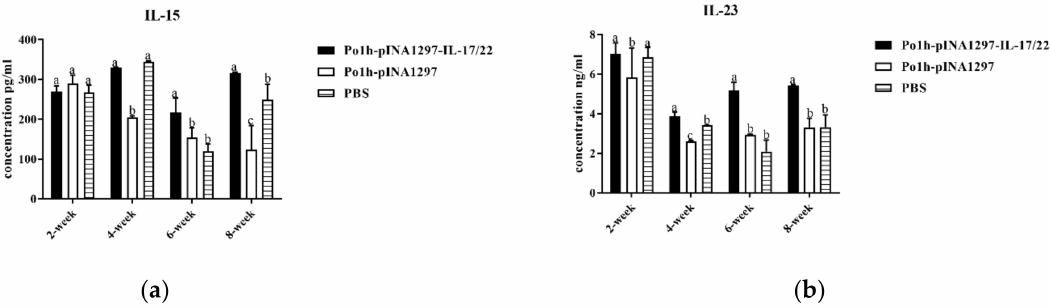
Figure 12. Changes in the IL-15 ( a ) and IL-23 ( b ) levels in the plasma of the